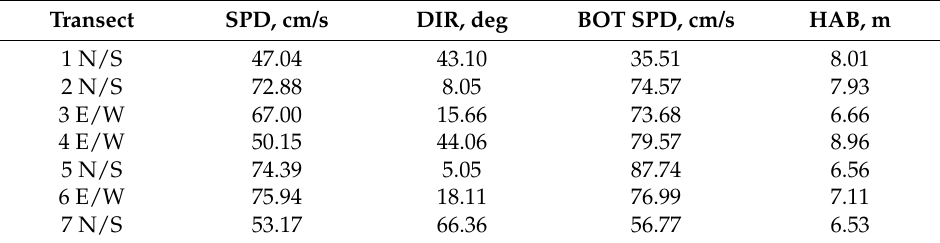
Table 2. Summary of ACDP Current Profiler Information.